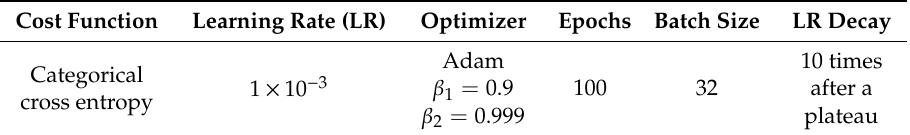
Table 2. Hyperparameters of the network.